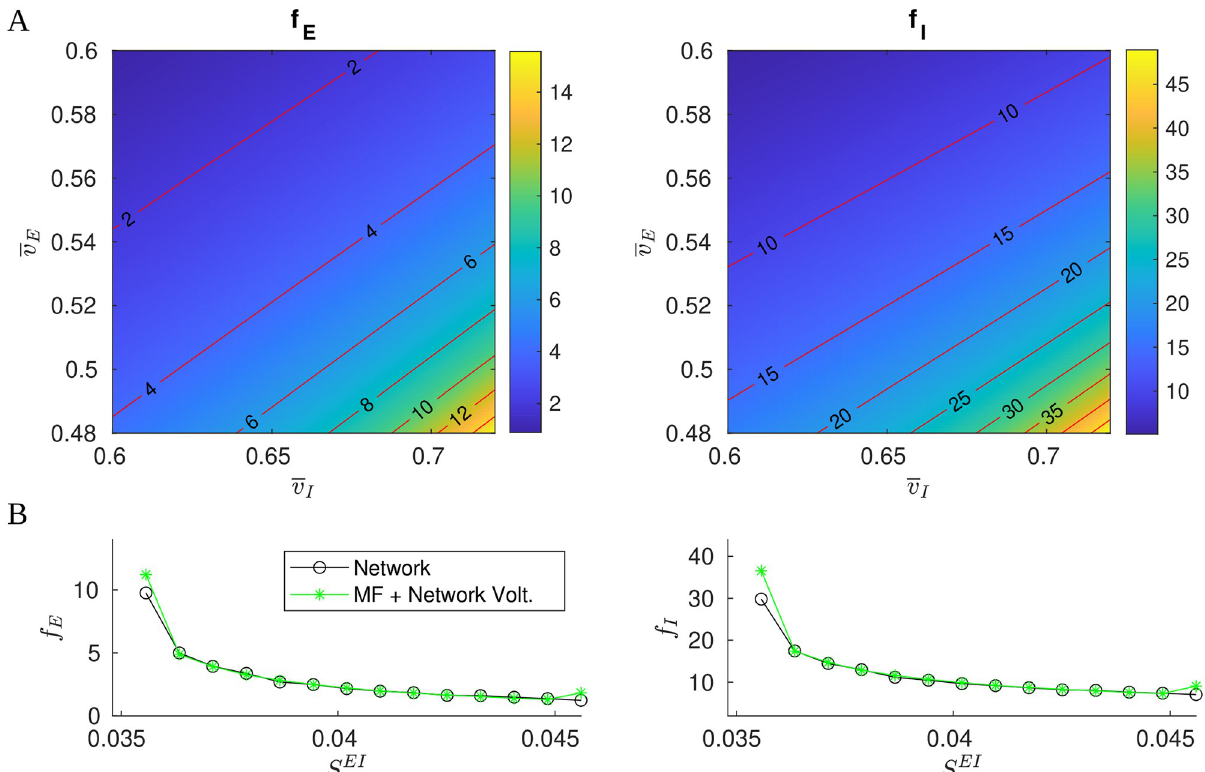
Fig 8. MF approximations. A. Contours of E/I firing rates as functions of ð � v from Eq (8) using network-computed mean voltages